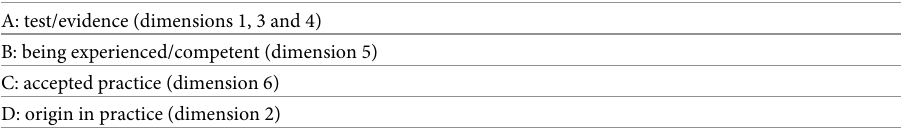
Table 2. Contracted dimensions, making up the ABCD-model